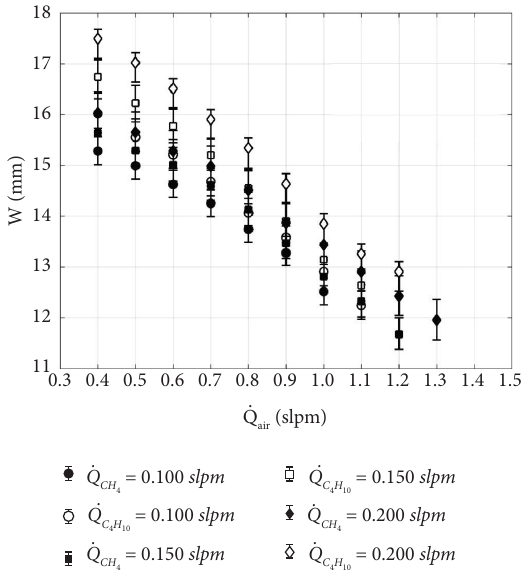
Figure 13: Variation of fame maximum width with the airfow rate for methane and n-butane.